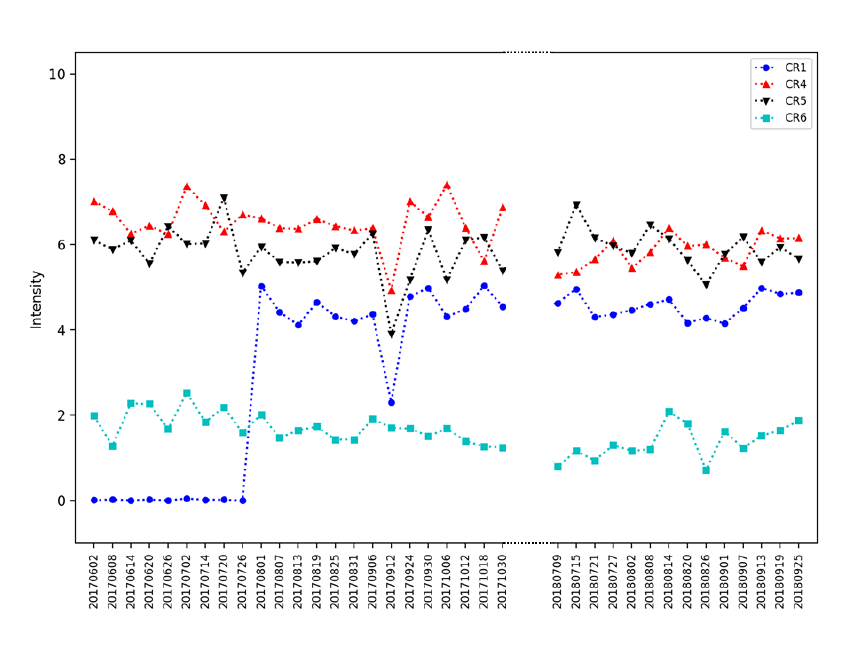
Figure 11. SAR image intensity time series in summer over four CRs installed in the study